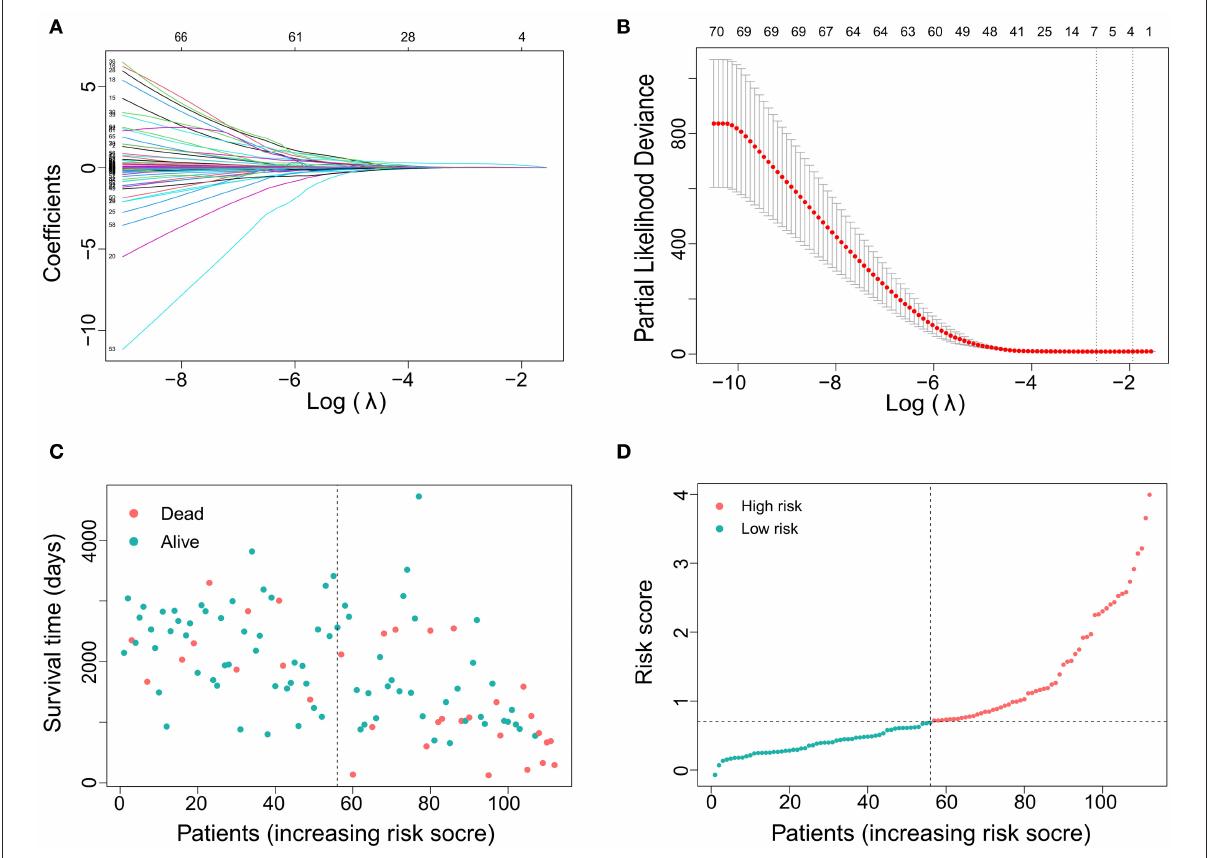
FIGURE1 Gene selection using the least absolute shrinkage and selection operator (LASSO) binary logistic regression model. (A) LASSO coefficient profiles of the 88 DE RNAs. A coefficient profile plot was produced against the log (lambda). (B) The area under the receiver operating characteristic (AUC) curve was plotted vs. log(l). Dotted vertical lines were drawn at the optimal values using the minimum criteria and the 1 standard error of the minimum criteria (the 1-SE criteria). (C) Distribution of survival time showing that survival time decreases with increasing risk score and the incidence of time to death increases. (D) Distribution curve showing the distribution of risk